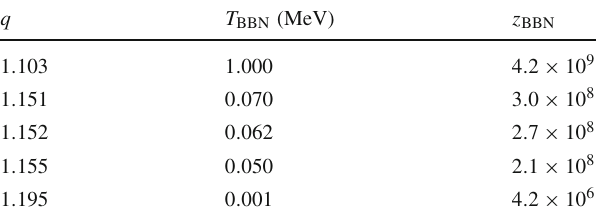
Table 1 Estimation for T BBN from non-Gaussian perspective. Since we estimate the factor q for T BBN , in this table we estimate T BBN from fluctuations around q ≈ 1 .